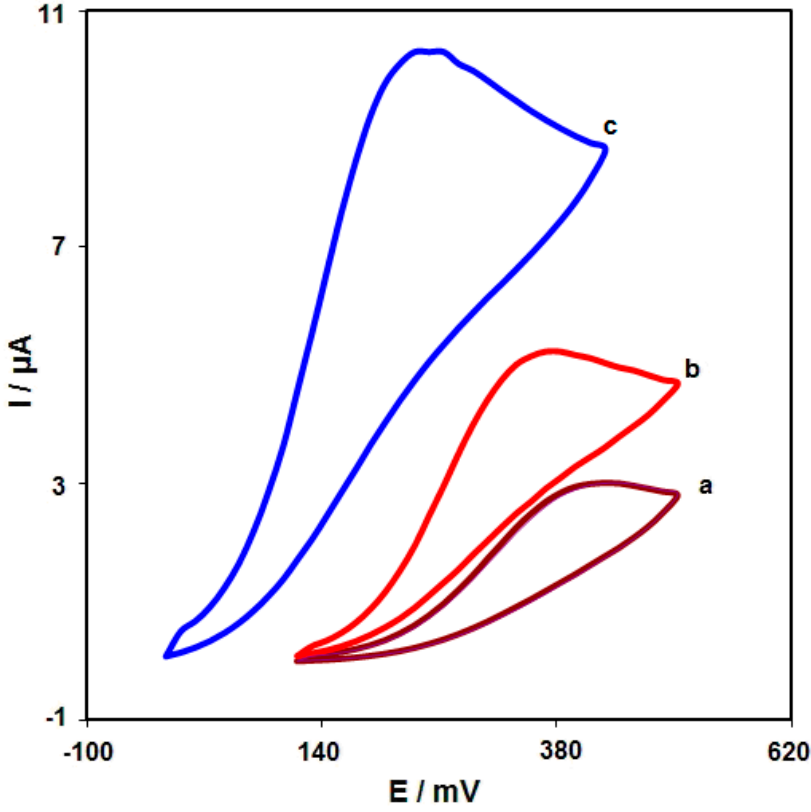
Figure 6. Cyclic voltammograms captured for oxidation of morphine (200.0 µM) in PBS (0.1 M; pH = 7.0) on: (a) unmodified SPGE; (b) graphene/SPGE; (c) graphene-Co 3 O 4 /SPGE with the scan rate of 50 mV/s.